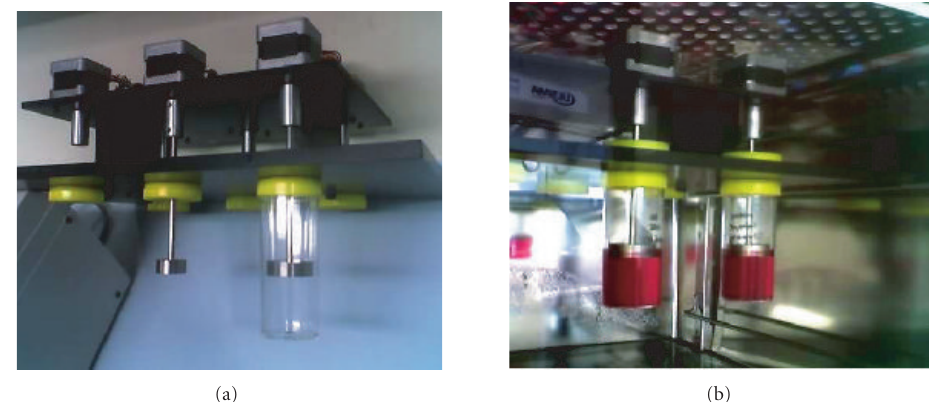
Figure 2: Photographs of the rotating disc bioreactor. (a) The bioreactor array prior to installation into a cell culture incubator. (b) Installed bioreactor with fixed vessels containing culture solutions with seeded EL-4